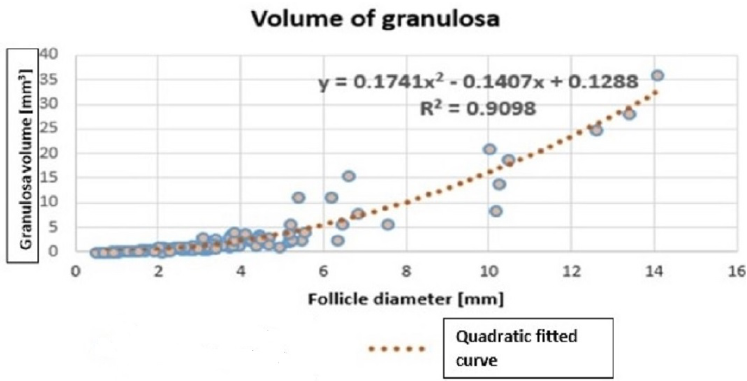
Figure 6. The model of volume of